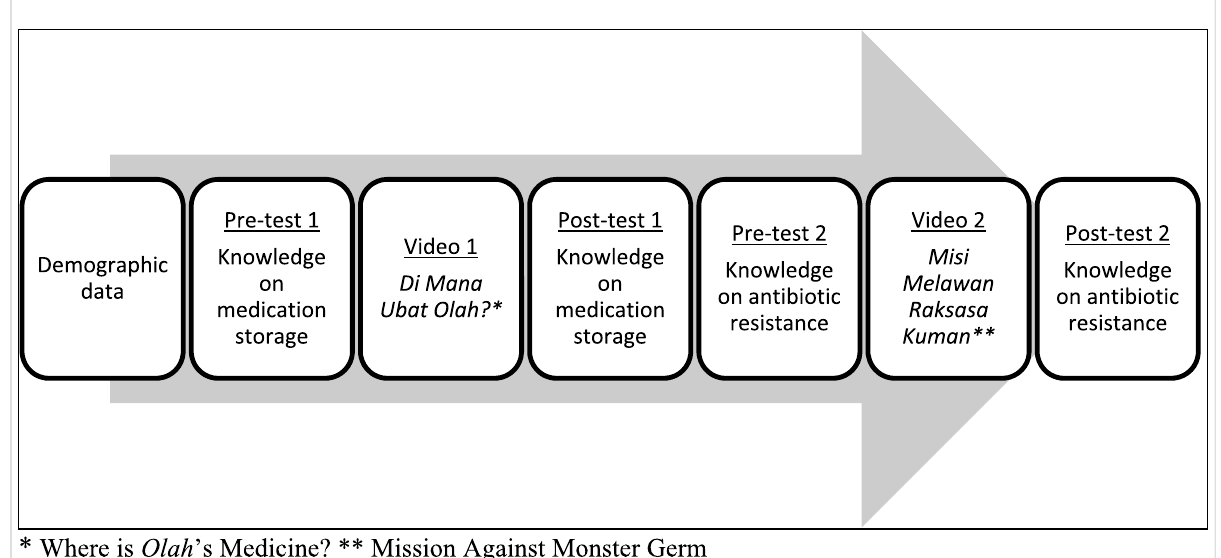
FIGURE 2 Flow of the